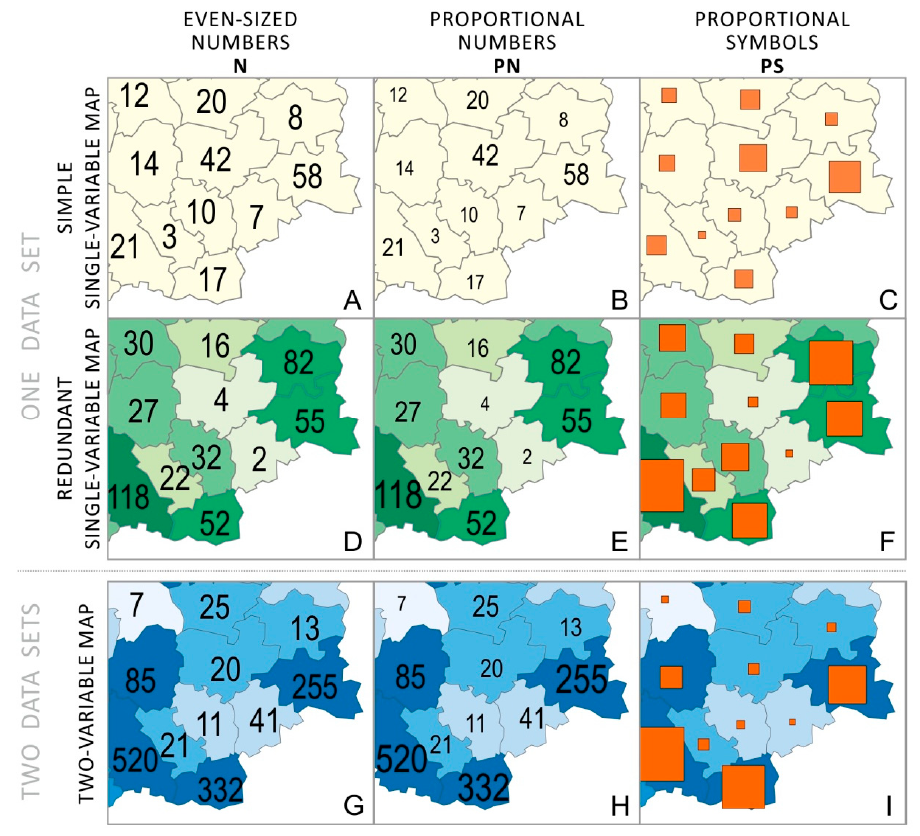
Figure 2. Fragments of map types used in the study. A–C: Simple single-variable maps presenting one data set by: ( A ) even-sized numbers, later abbreviated as “N”, ( B ) proportional numbers “PN”, ( C ) proportional symbols “PS”. D–F: ( D ) Redundant single-variable maps also presenting one-data set by choropleth map and also by: even-sized numbers “N”, ( E ) proportional numbers “PN”, ( F ) proportional symbols “PS”. G–I: ( G ) Two-variable maps presenting two data sets using choropleth map and: even-sized numbers “N”, ( H ) proportional numbers “PN”, ( I ) proportional symbols “PS”.